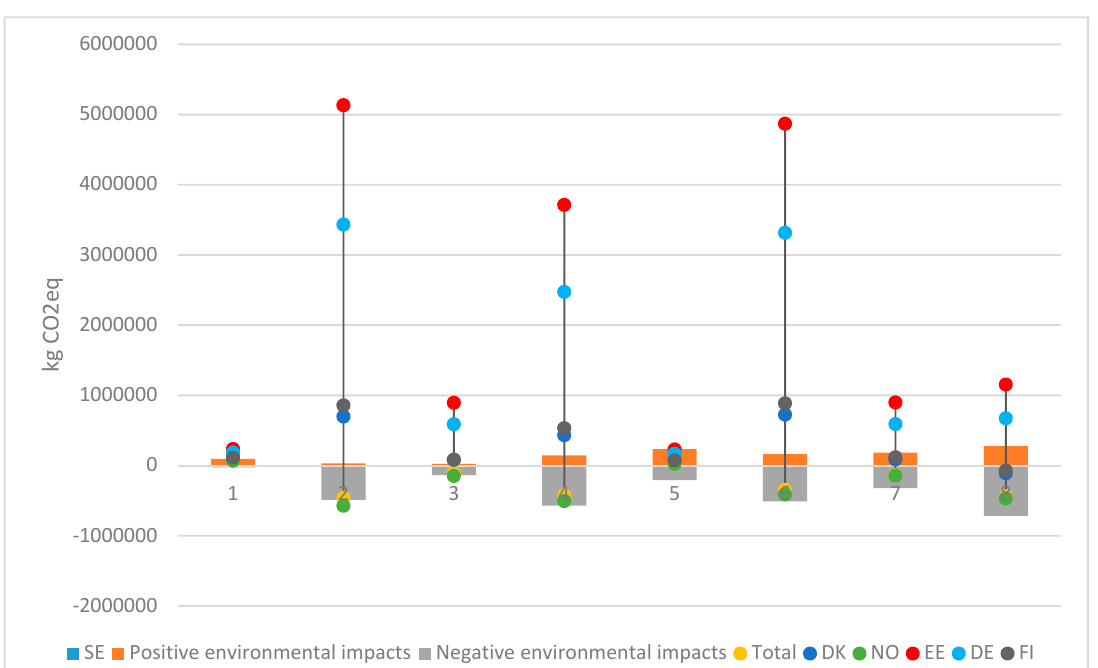
Figure 8. GWP for the scenarios with sensitivity analysis for different electricity mixes.